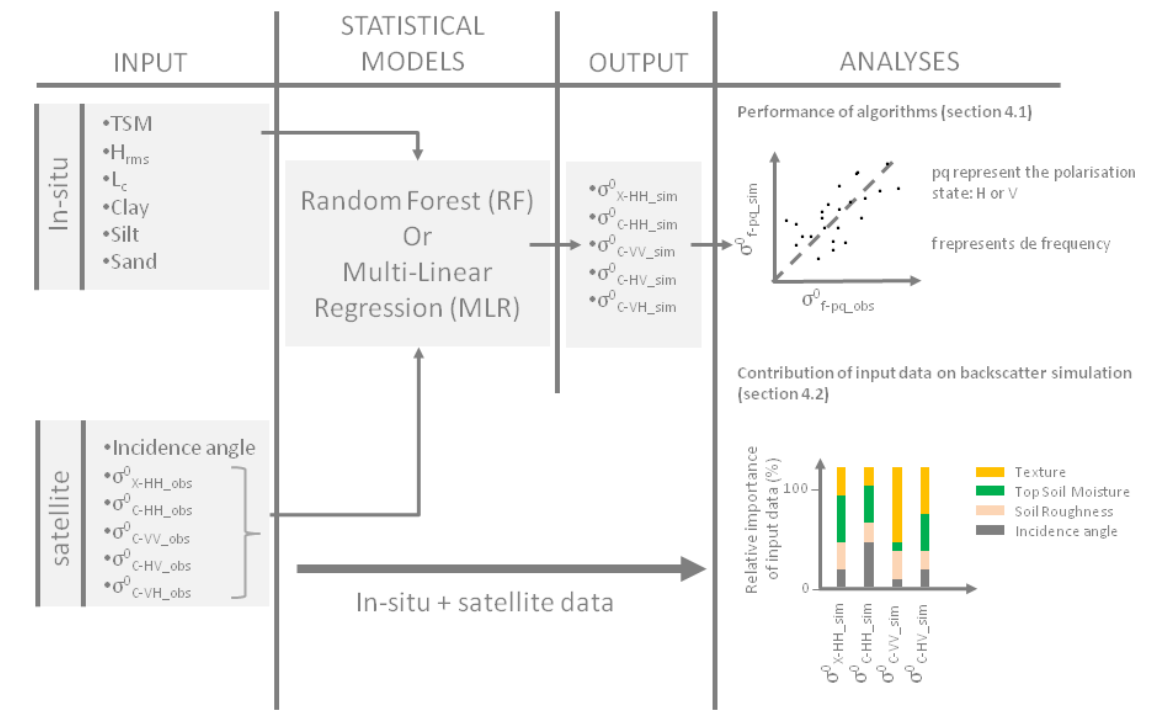
Figure 6. Synopsis of the